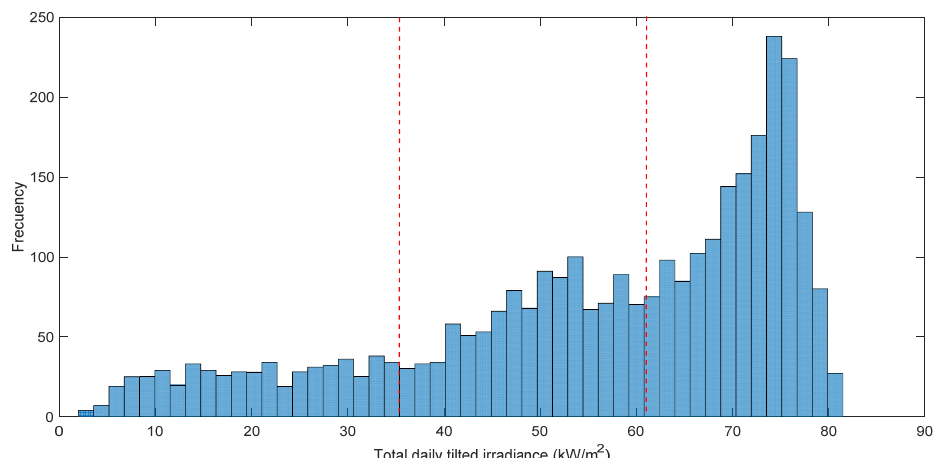
Figure 2. Histogram corresponding to the daily total values of irradiance recorded on the plane of the PV modules during the period 2011–2020.